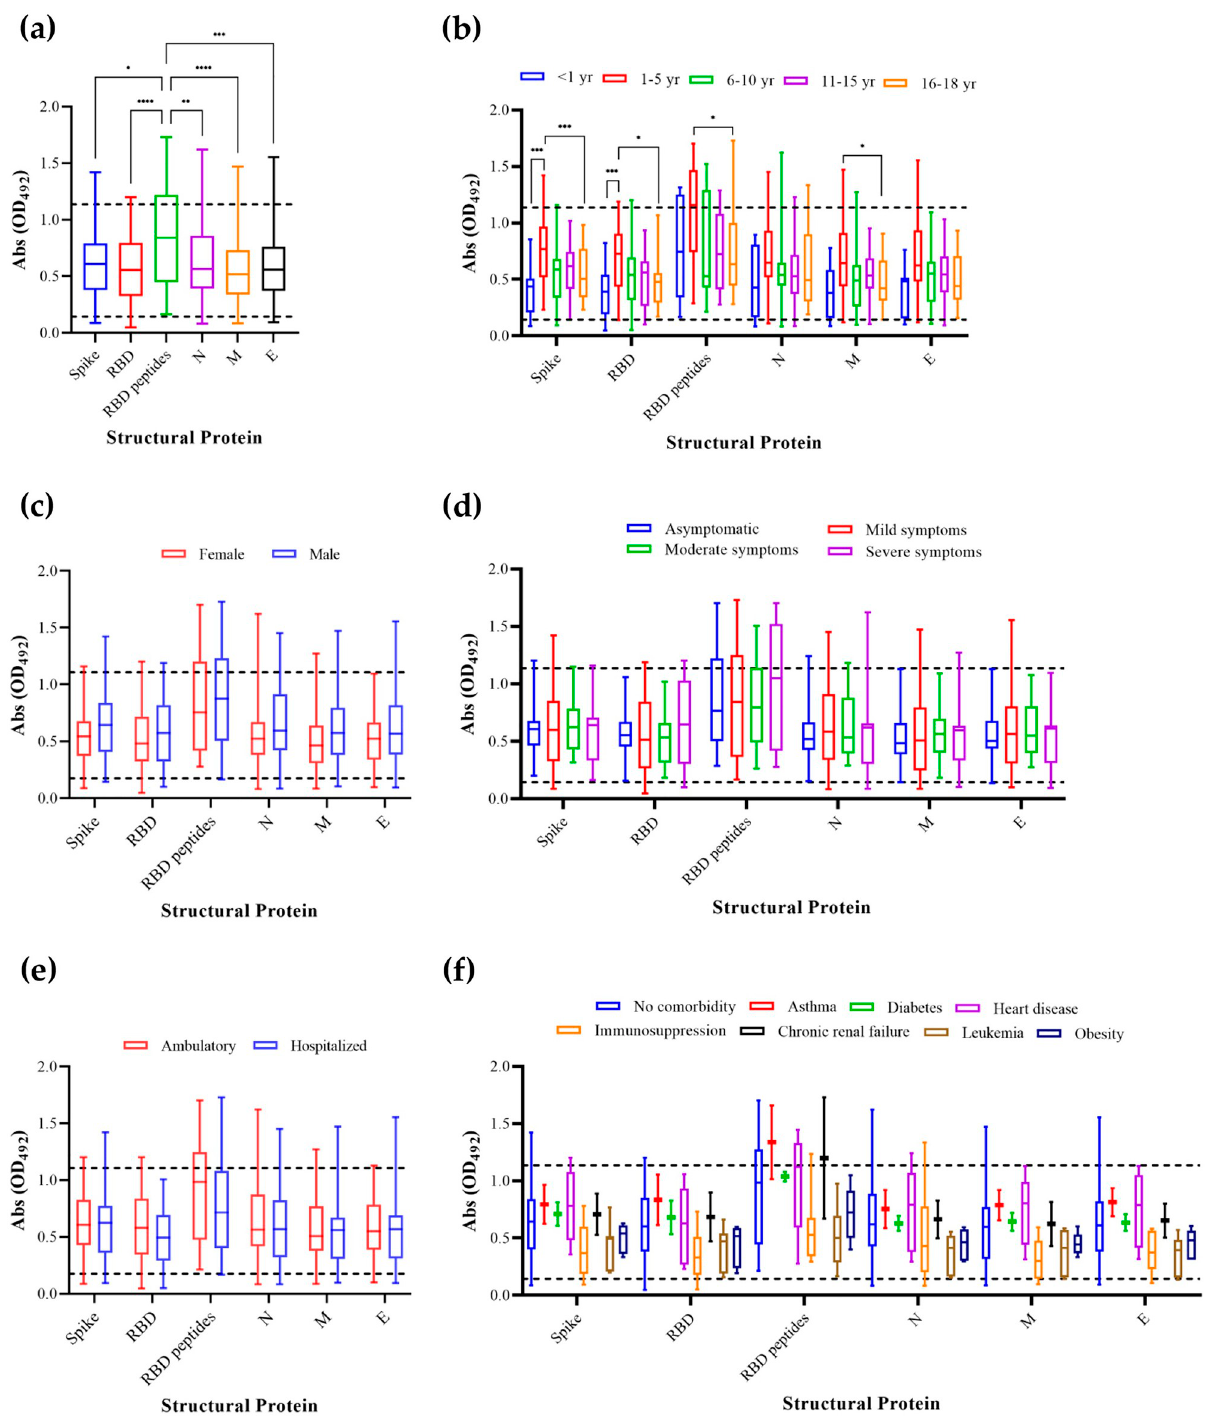
Fig 2. Evaluation of IgG (whole molecule) antibodies using SARS-CoV-2 S (trimer, RBD, and RBD peptides), N, M, and E proteins in the serum samples of Mexican children and adolescents with COVID-19. IgG determination of whole molecule IgG antibodies was performed using ELISA in (a) total IgG antibodies, comparisons between IgG and (b) age, (c) sex, (d) severity of illness, (e) patient status, and (f) comorbidity. Bars represent the median of 100 determinations from the serum samples of children and adolescents with COVID-19 performed in duplicate. The top line represents the median value of 10 COVID-19-positive patients, and the bottom line indicates the median value of 10 COVID-19-negative volunteers. Statistical significance was determined using ANOVA followed by the Kruskal–Wallis post hoc test. Statistical significance was considered when � p � 0.05 to > 0.01, �� � 0.01 to > 0.002, ��� � 0.001 to > 0.0001, and ��� � 0.0001.